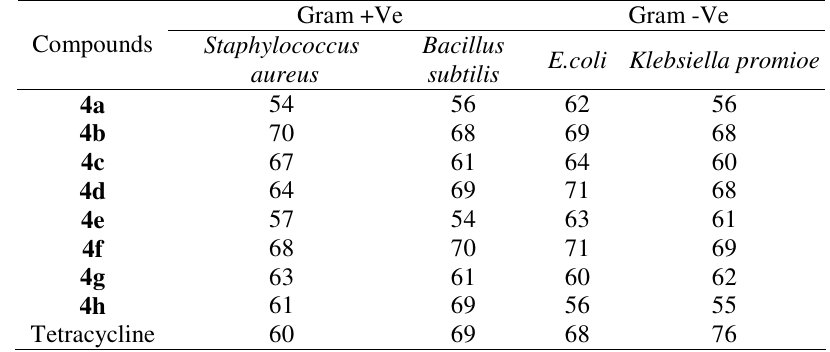
Table 6. Antibacterial activity of compounds ( 4a-h )